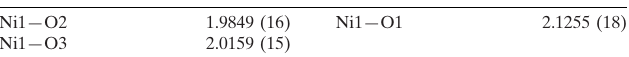
Selected bond lengths (A˚ ).